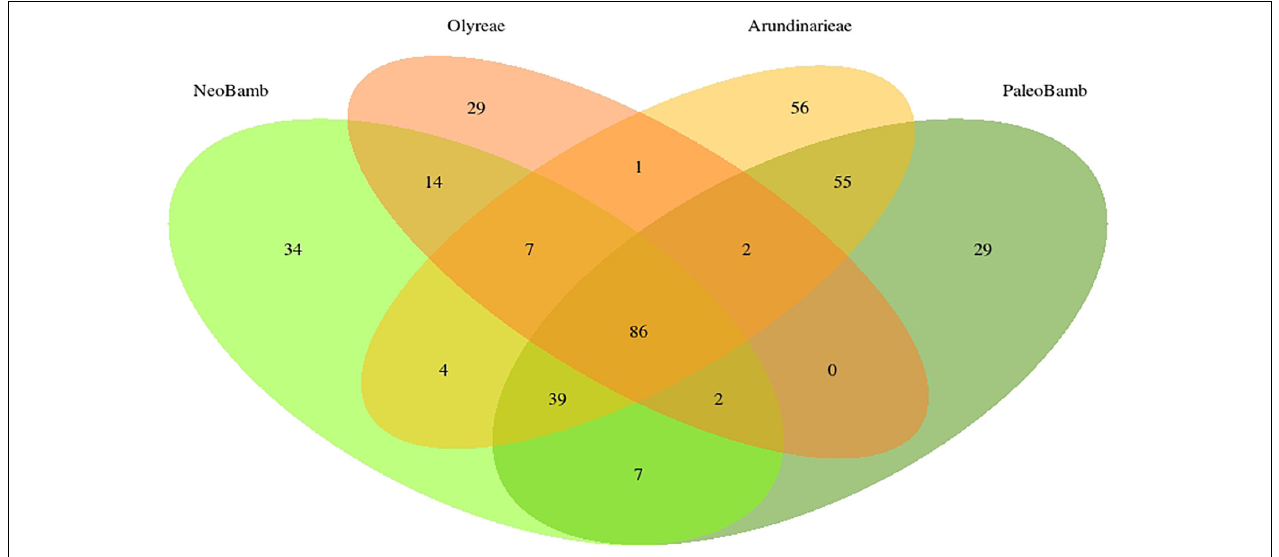
FIGURE 3 | Number of species-specific and shared repeat TE clusters in the bamboo clades. Only the 365 most abundant clusters were used to draw the Venn diagram. Out of these 365 clusters, 86 are found in all four of the studied